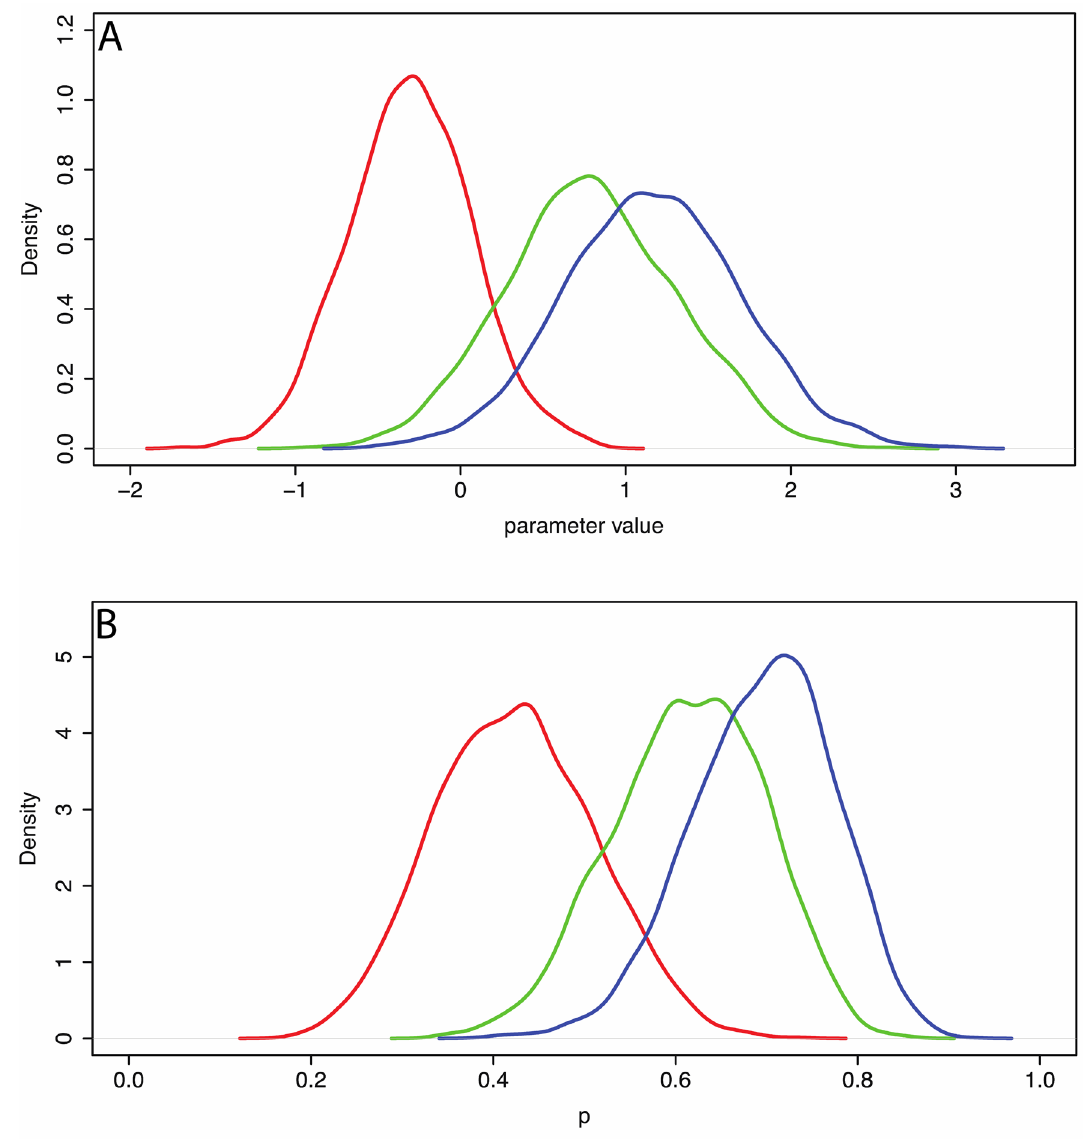
Figure 3. Posterior distributions of the parameters and probabilities. ( A ) The posterior distributions for γ 0 (red), γ 1 (green) and γ 2 (blue). ( B ) The posterior distributions of p none (red), p medium (green), and p high (blue) defined in Eq.